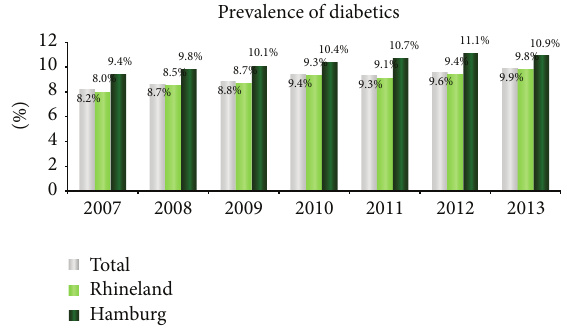
Figure 1: Prevalence of diabetics covered by AOK RH, 2007–2013.